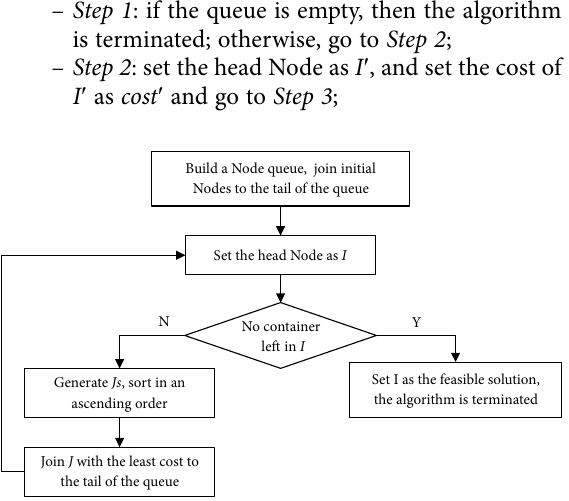
Fig. 4. The framework of greedy algorithm